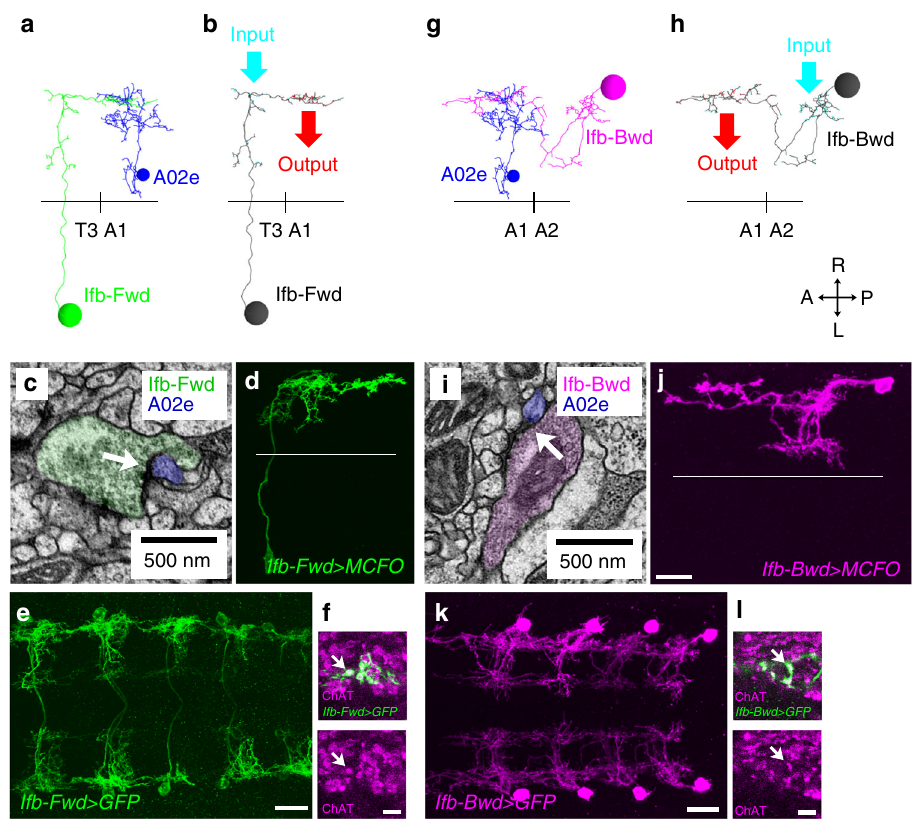
Fig. 2 Intersegmental projection of Ifb-Fwd and Ifb-Bwd interneurons. a – f Analyses of Ifb-Fwd interneuron. a – c Neuron reconstruction from EM. a Dorsal view of the Ifb-Fwd neuron (green) and its target A02e (blue). b Location of the synaptic inputs (cyan) and outputs (red) in Ifb-Fwd. c A synaptic contact between Ifb-Fwd and A02e (arrow). d The morphology of Ifb-Fwd as revealed by clonal analysis in SS02065>MCFO (multi-color fl ip-out). A dorsal view. e SS02065-Gal4 speci fi cally targets Ifb-Fwd. A dorsal view of an SS02065-Gal4 > mCD8::GFP CNS stained for GFP. f Ifb-Fwd is ChAT-positive. Dorsal view of an SS02065 > mCD8::GFP CNS ( n = 5 larvae). g – l Analyses of Ifb-Bwd interneuron. g – i Neuron reconstruction from EM. g Dorsal view of the Ifb-Bwd neuron (magenta) and its target A02e (blue). h Location of synaptic inputs (cyan) and outputs (red) in Ifb-Bwd. i Synaptic contacts between Ifb-Bwd and A02e (arrow). j The morphology of Ifb-Bwd as revealed by clonal analysis in SS026694>MCFO . A dorsal view. k SS026694-Gal4 speci fi cally targets Ifb- Bwd. A dorsal view of an SS026694>mCD8::GFP CNS stained for GFP. l Ifb-Bwd is ChAT-positive. Dorsal view of an SS026694>mCD8::GFP CNS ( n = 5 larvae). Black horizontal lines in ( a , b , g , h ) and white horizontal lines in ( d , j ) indicate the midlines. Scale bar, 20 µ m ( d , e , j , k ) and 5 µ m ( f , l